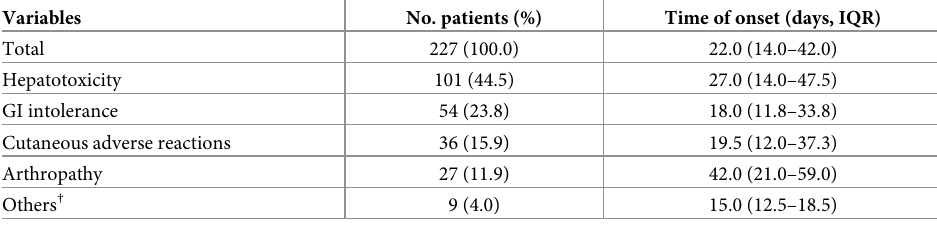
Table 2. Types and onset time of severe adverse events due to